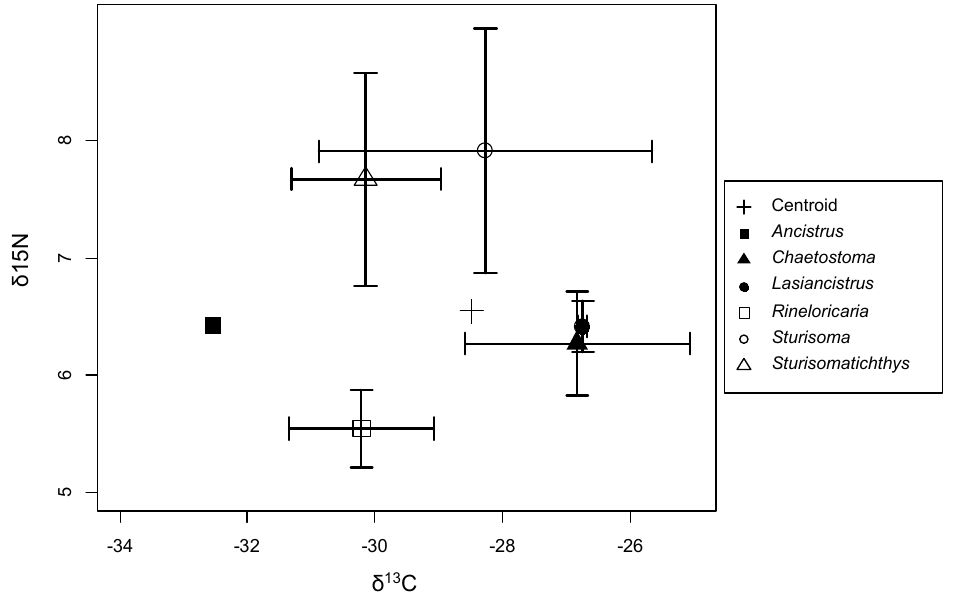
Figure 2. Stable isotope centroids for all data (cross symbol) and individual loricariid taxa averaged across all sampling sites. Dark symbols are genera in Hypostominae, and white symbols are genera in Loricariinae. Error bars represent standard deviation, and sample sizes are listed in Table 2.